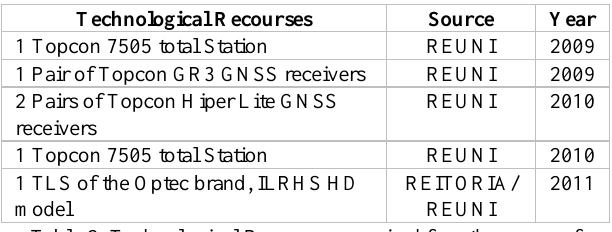
UFRGS: Mention of the term "Photogrammetry"